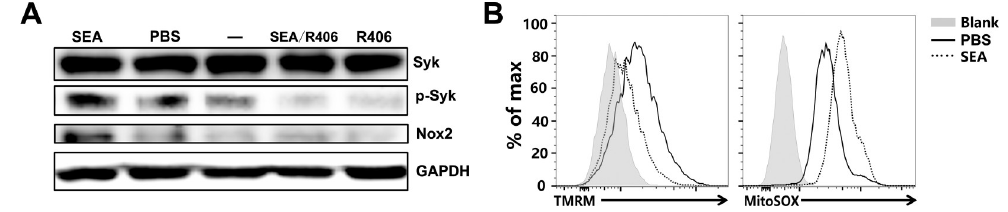
Fig 6. SEA stimulate ROS production of macrophages by NADPH oxidase and mitochondria. (A) J774A.1 cells were pretreated with Syk inhibitor R406 and then stimulated with PBS or 40 μ g/m SEA for 24 hours. Cells were collected and whole cell lysates were extracted for detecting Syk, p-Syk, and Nox2 by immunoblotting. GAPDH was used as an internal control. (B) J774A.1 cells were stimulated with PBS or 40 μ g/m SEA for 24 hours. Mitochondrial membrane potentials and ROS in cells were measured by FCM analysis using TMRM and MitoSOX, respectively. Data are representative of two independent experiments, each with